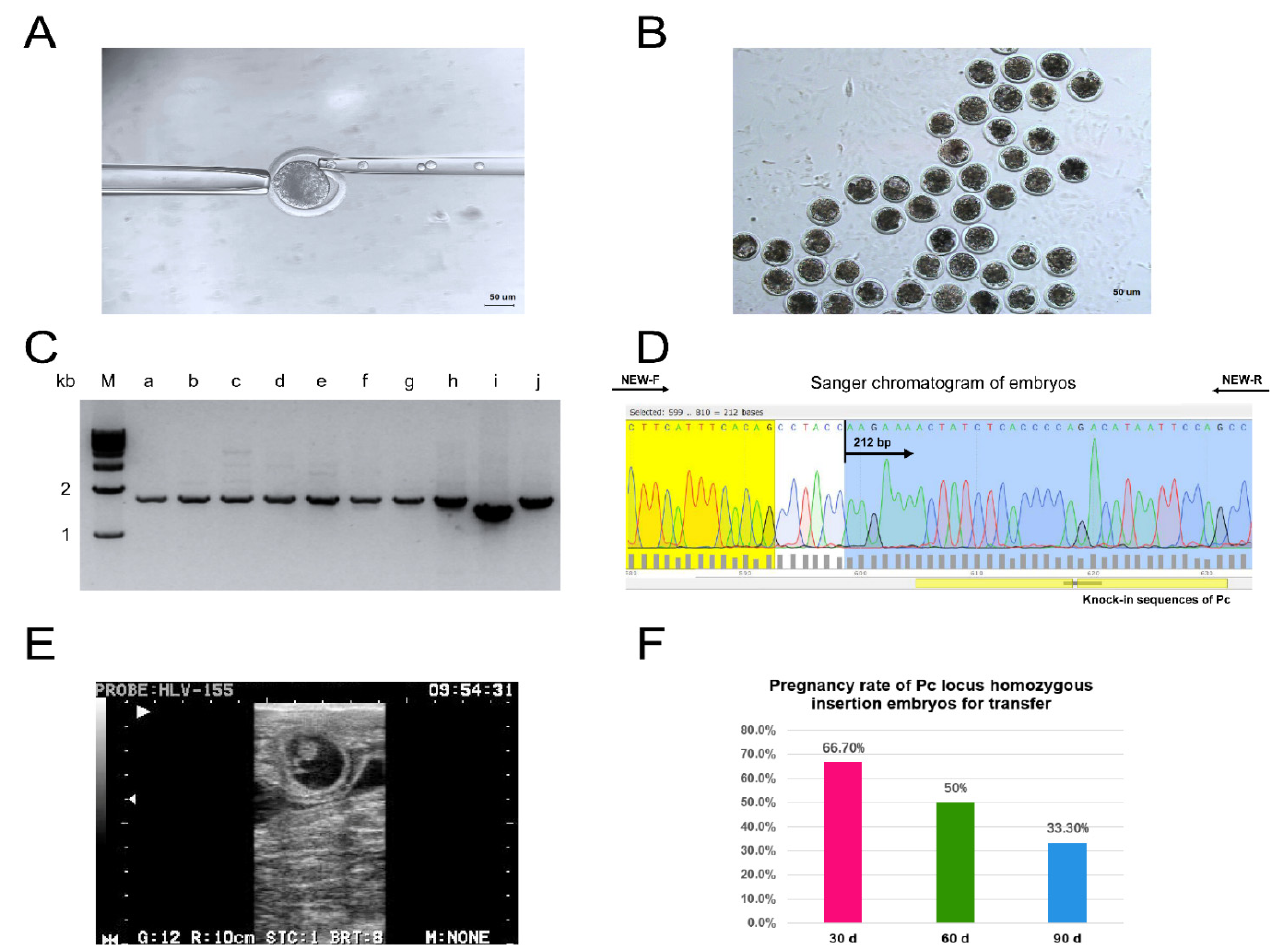
Figure 1. Preparation and identification of polled bovine embryos. ( A ) Transplantation of donor cells into enucleated oocytes. ( B ) Somatic cell nuclear transfer embryos in culture for 7 days. ( C ) PCR identification of blastocyst agarose gel electrophoresis results. (a–h) are eight somatic cell clones obtained from Pc site-pure insertions of hornless phenotypic blastocysts, (i) is the whole genome of wild-type horned Holstein, (j) is a cell line obtained from gene-edited Pc site homozygous insertions. ( D ) Sanger sequencing chromatograms of the Pc locus in somatic cell nuclear transfer embryos. ( E ) Ultrasound test results 30 days after embryo transfer. ( F ) Pregnancy rate of Pc locus homozygous insertion embryos for transfer.